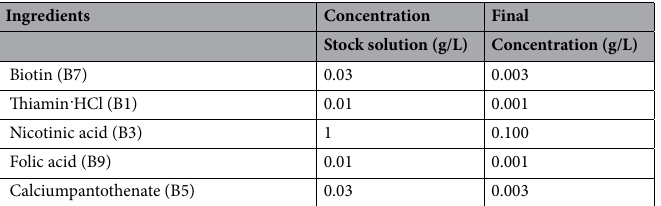
Table 1. Composition of the chemically defined medium. *These components were tripled for the improved chemically defined medium.